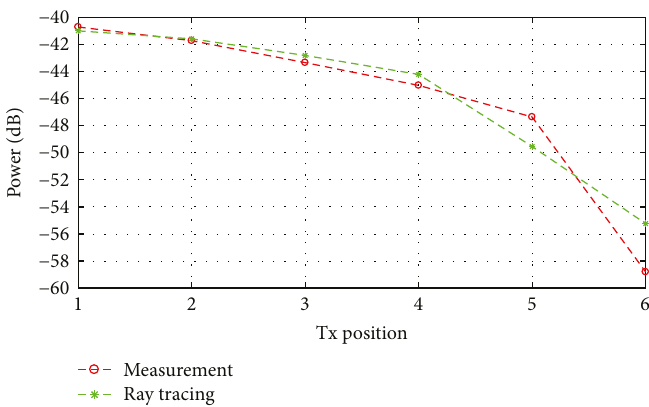
Figure 13: Measured and RT-simulated received power for all Tx positions for the basement scenario.